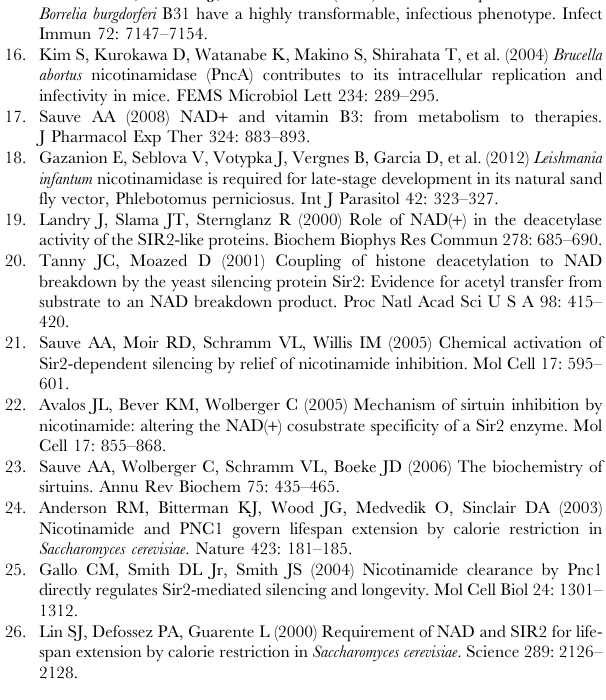
Figure S2 SDS-PAGE of the pure OiNIC and enzyme cross-linked with dimethylsuberimidate. M: molecular weight standards (New England Biolabs: P7708S). Lane 1: Purified OiNIC. Lane 2: Purified OiNIC with DMS (3 mg/mL). Protein monomer is about 21 kDa, protein dimer is about 42 kDa. Figure S3 Inhibition of OiNIC by nicotinaldehydes. The Lineweaver-Burke plots for competitive inhibition by nicotinalde- hyde (A) and 5-Bromo-nicotinaldehyde (B). Inhibition reactions